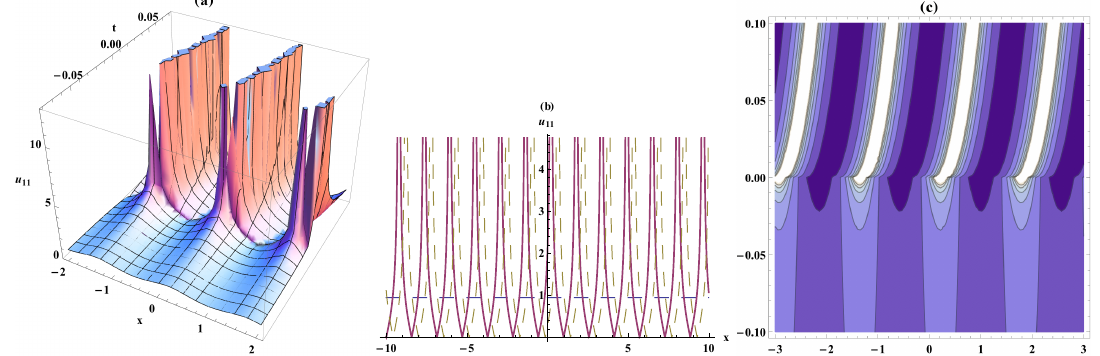
Figure 6. Periodic solitary wave, the bistable wave amplitude, and contour plots for Equation (29). On the respective interval { x , − 2.05,2.05 } , { t , − 0.08,0.08 } , { x , − 10,10 } , { t , − 1,1 } , { x , − 3,3 } , { t , − 0.1,0.1 } .